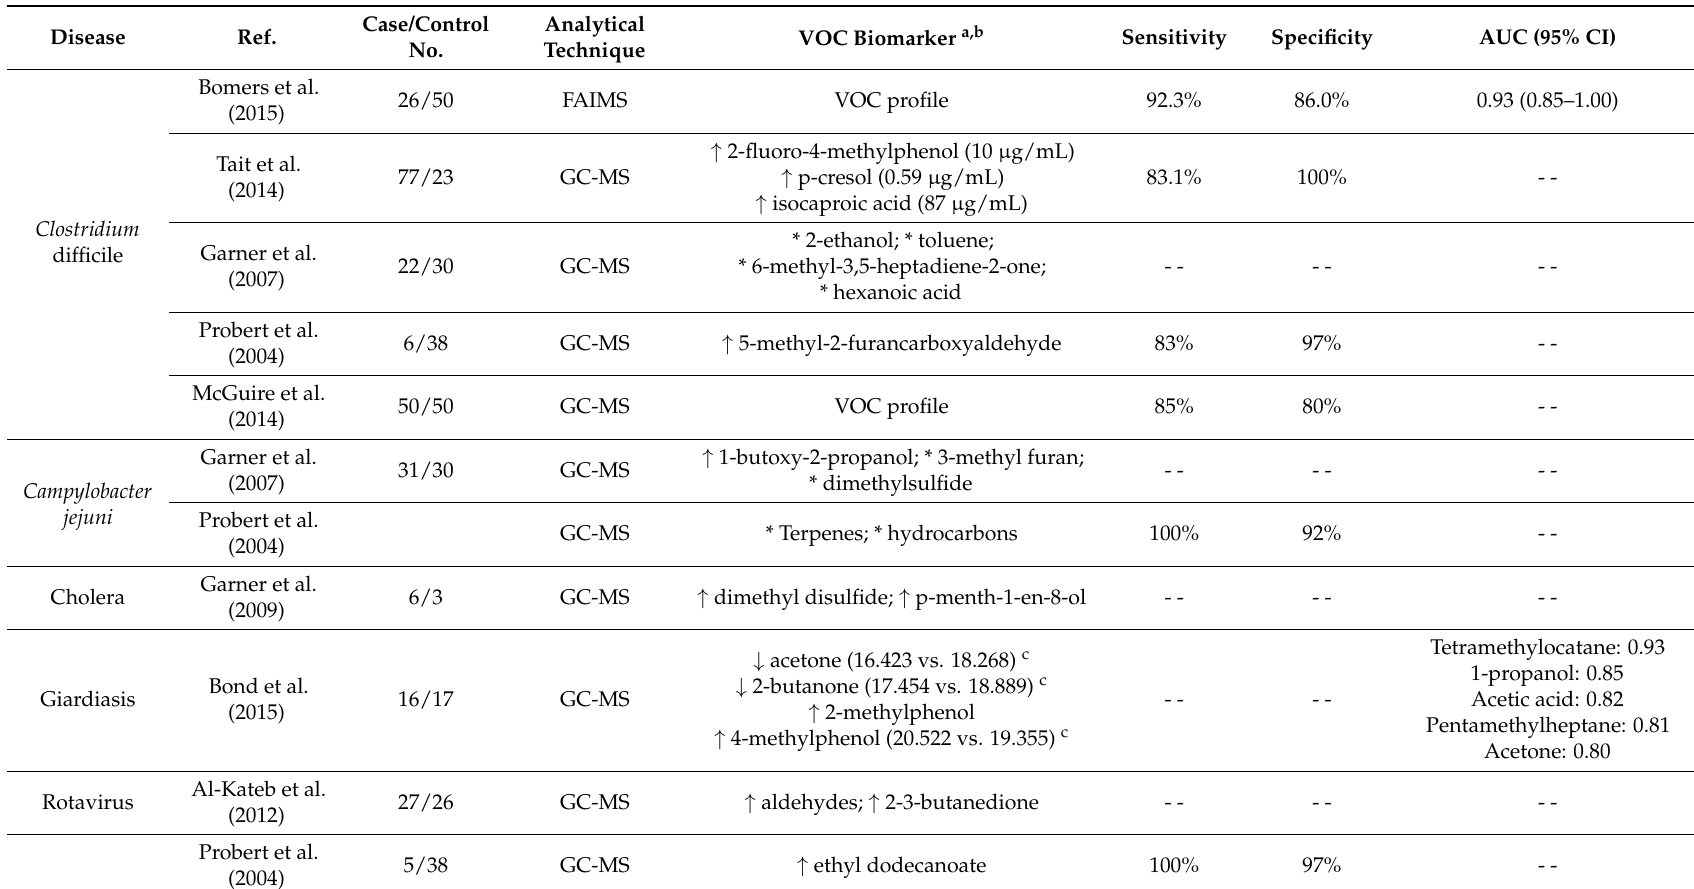
Table 2. Overview of studies on fecal VOC analysis in infectious